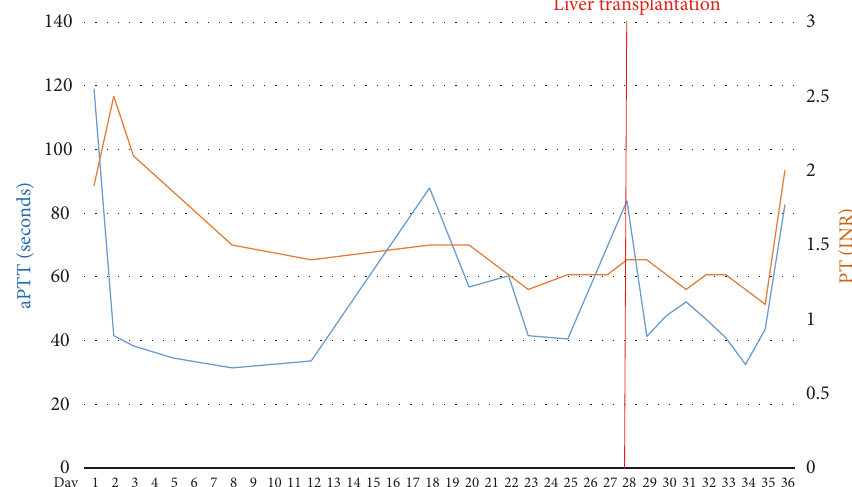
Figure 4: Trend of PT/aPTT.